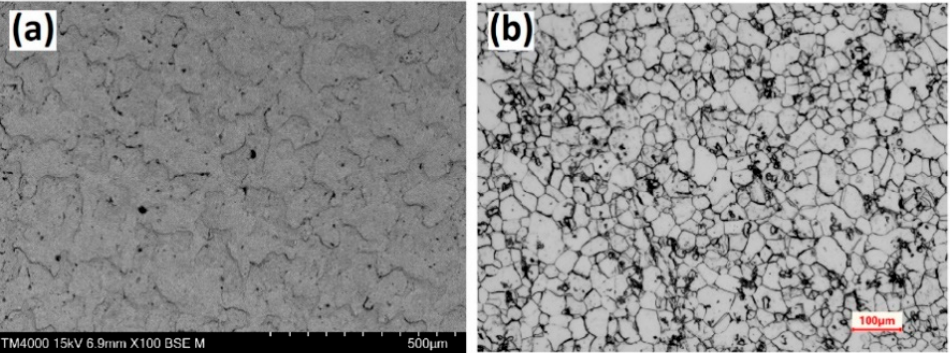
Figure 2. ( a ) SEM image of as-received carbon steel sheets; ( b ) microstructural (optical) image of CR1 Carbon Steel Sheet after etching in 2%